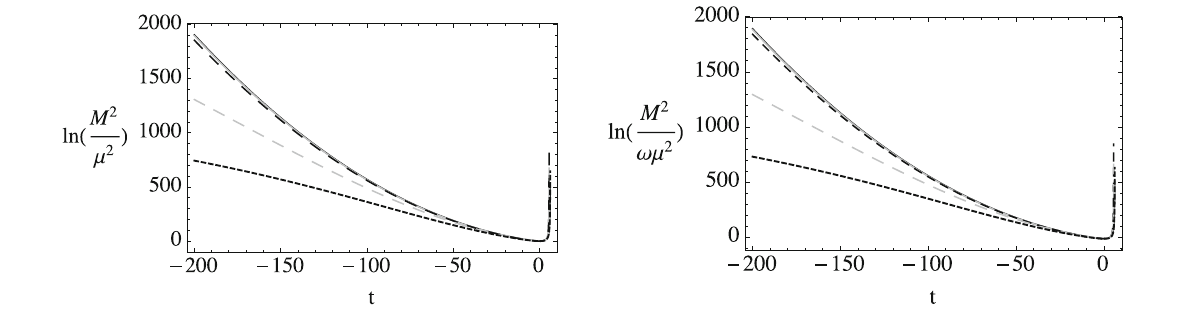
Fig. 8 The running of induced ln ( M 2 /μ 2 ) and ln ( M 2 /ωμ 2 ) for the case f 2 ∗ = 10 − 8 , λ ∗ = 0 . 1, ρ ∗ = 1 . 5 and (cid:2) = 10 − 16 . The flow is com- puted for five different values of ξ ∗ = 10 2 (black solid line), 10 3 (grey solid line), 10 4 (big dashed black line), 5 × 10 4 (big dashed grey line)